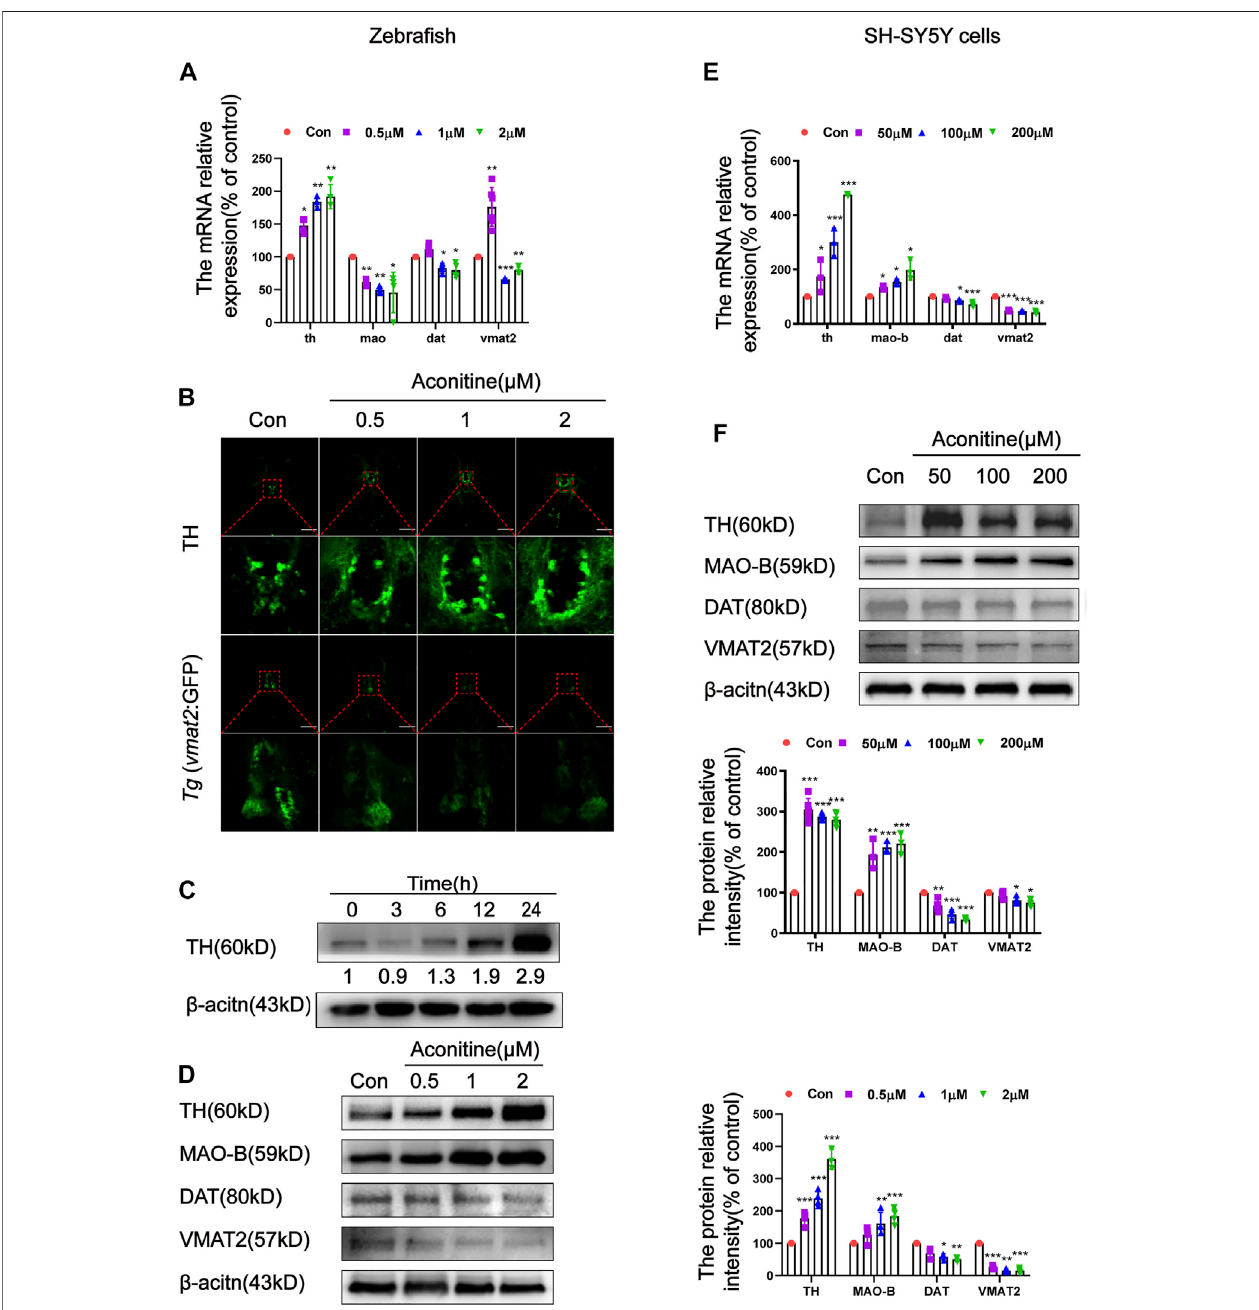
FIGURE 4 | Effects of aconitine on TH, MAO, DAT and VMAT2 expressions in zebra fi sh larvaes and SH-SY5Y cells. (A) The mRNA expressions of th , mao , dat , vmat2 with aconitine exposure in zebra fi sh larvaes, n = 6. (B) TH and VMAT2 positive cells were investigated using immunostaining and Tg (vmat2:GFP) transgenic zebra fi shlarvaes, respectively, n =5. (C) Effect ofdifferentexposure times of1 μ Maconitine ontheprotein expression ofTH, n =4. (D) Theprotein levels ofTH,MAO-B, DATandVMAT2withaconitineexposureinzebra fi shlarvaes, n =4. (E) ThemRNAexpressionsof th , mao-b , dat , vmat2 withaconitineexposureinSH-SY5Ycells, n = 3. (F) The protein levels of TH, MAO-B, DAT, and VMAT2 with aconitine exposure in SH-SY5Y cells, n = 7. All photographs in which the green fl uorescence represented the immune-reactive cells were taken under a confocal microscope (100×). The values are expressed as mean ± SD. * p < 0.05, ** p < 0.01, *** p < 0.001 vs. control